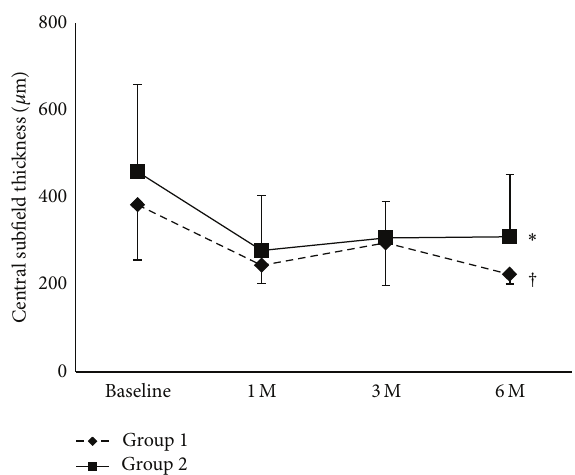
Figure 2: Central subfield thickness assessed with spectral domain optical coherence tomography in both eyes of Group 1 and Group 2. Notes: ∗ 𝑃 < 0.05 and † 𝑃 < 0.01 , compared with the respective baseline value (just before the second intravitreal bevacizumab